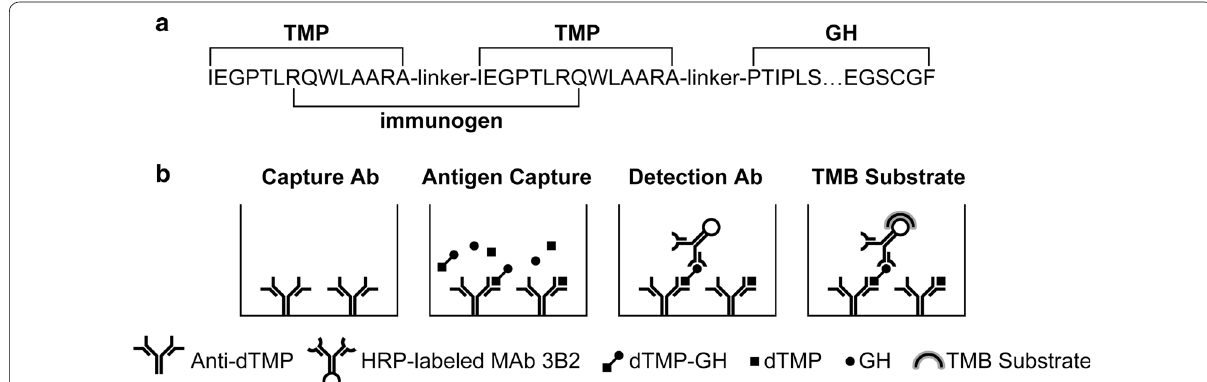
Fig. 1 Schematic diagrams of the immunogen amino acids sequence and the ELISA of dTMP-GH detection described in this study. a A schematic diagram of the immunogen amino acids sequence. b The strategy of the ELISA for dTMP-GH